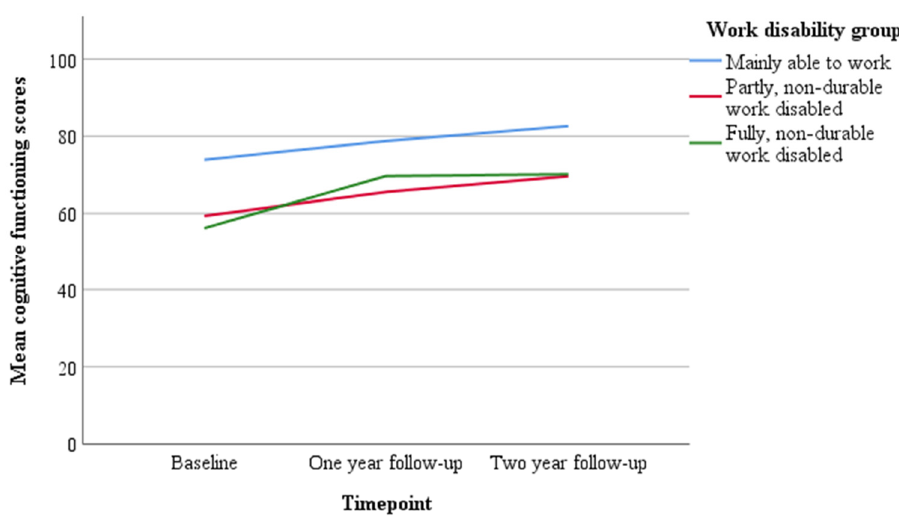
Figure 2. Trajectories of cognitive functioning for separate work disability group.